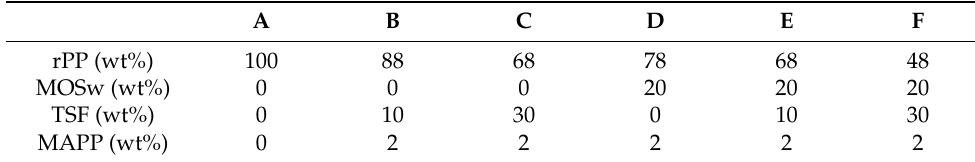
Table 1. Formulations of the